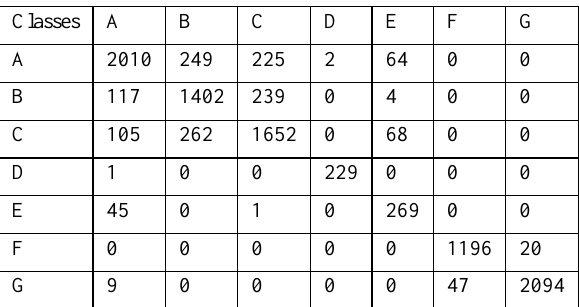
Table 5: Confusion matrix of SVM